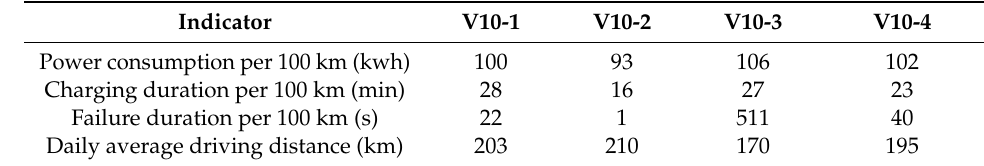
Table 9. Selection Factor Data for Group